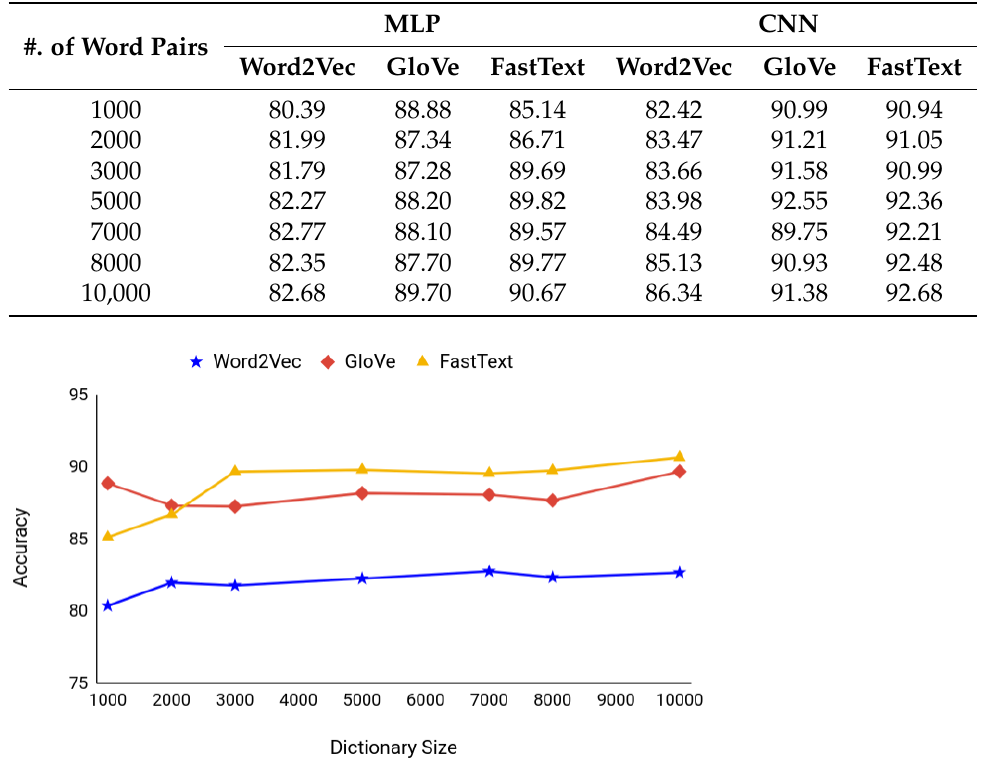
Figure 9. Graphical representation of Pairwise Accuracy of MLP Network over various dictionary lengths. The X-axis represents the dictionary sizes, and the Y-axis represents the accuracy.